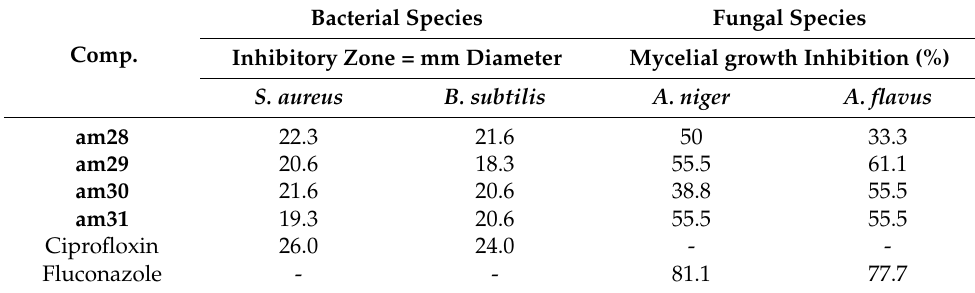
Table 13. Antimicrobial activity of the compounds (am28 – am31 ).